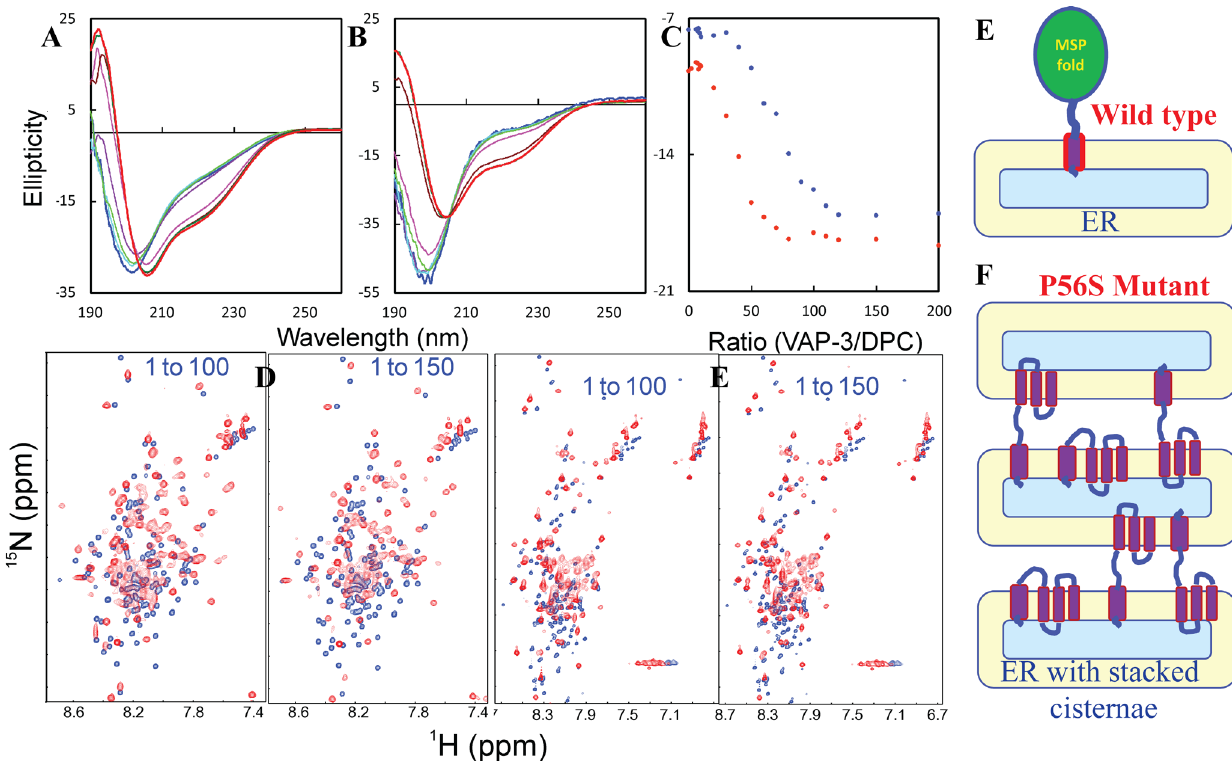
Figure 23. Transformation of the P56S-MSP and VAPB-3 into integral membrane proteins. ( A )–( B ) Far-UV CD spectra of P56S-MSP ( A ) and VAPB-3 ( B ) in the absence of (blue) and in the presence of DPC at different ratios (protein:DPC): 1:6 (cyan), 1:10 (bright green), 1:20 (purple), 1:50 (pink), 1:100 (brown), 1:150 (green) and 1:200 (red). ( C ) Ellipticity values at 222 nm of P56S-MSP (red) and VAPB-3 (blue) vs. the ratios (protein:DPC). ( D )–( E ) 1 H– 15 N NMR HSQC spectra of P56S-MSP ( D ) and VAPB-3 ( E ) in the absence of (blue) and presence of DPC at two ratios (red) as indicated (P56S:DPC). ( E ) Cartoon model of the wild-type VAPB protein anchored onto ER membrane, with the well-folded MSP domain in the cytosol. ( F ) Cartoon model proposed here to rationalize a recent report that the P56S VAPB protein triggers the formation of a novel form of organized smooth endoplasmic reticulum with stacked cisternae. Briefly, the P56S-MSP domain becomes insoluble in the cytosol and thus will have a strong preference to insert into ER cisternae. If the C-terminal transmembrane fragment and P56S-MSP insert into different ER cisternae, a novel form of organized smooth ER will form with stacked